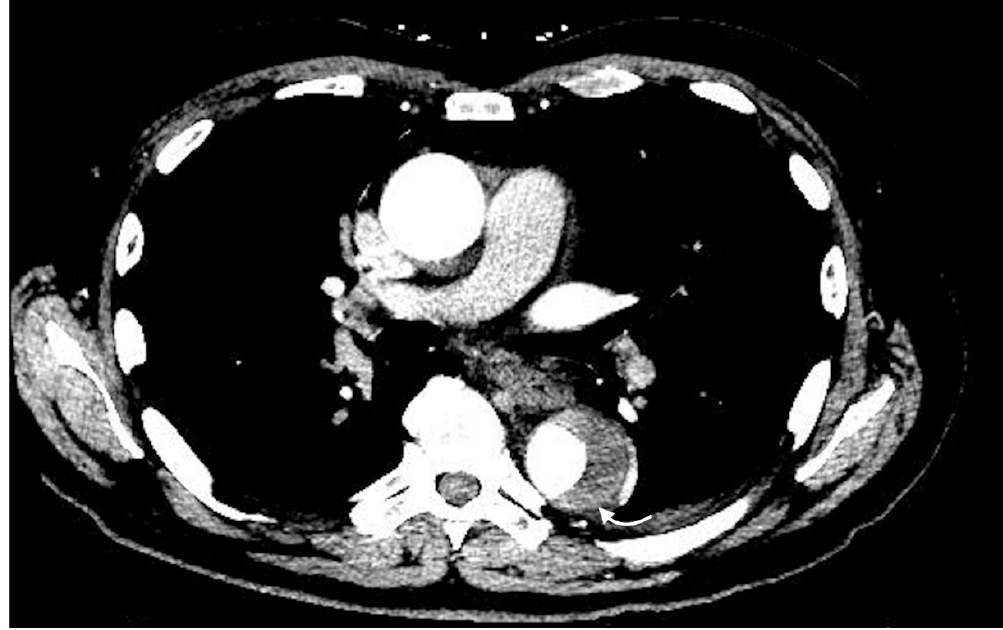
Figure 9. Axial contrast-enhanced arterial phase image demonstrating a crescent-shaped intramural hematoma (curved arrow) in the descending aorta.